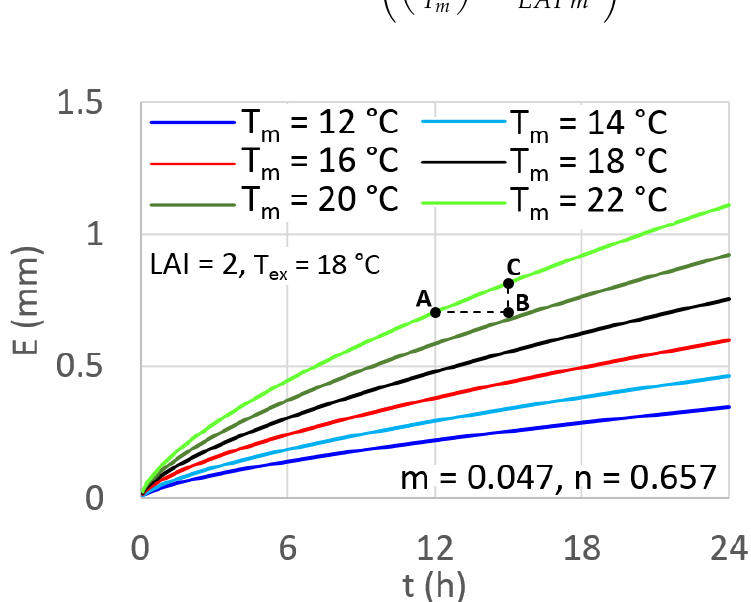
Figure 6. For LAI = 2 and an experimental temperature, T ex = 18 °C, evaporation losses by canopy per unit surface leaf, E (mm), during the time t (h), starting from the interception capacity ( E = 0, t = 0), with air temperature, T m (°C), as a parameter. For T m = 22 °C and DS = 3 h, the figure also illustrates the evaporation loss, ∆ E (mm), corresponding to the segment B–C, starting from an initial condition A = ( t 0 , E 0 ) drier than saturation.